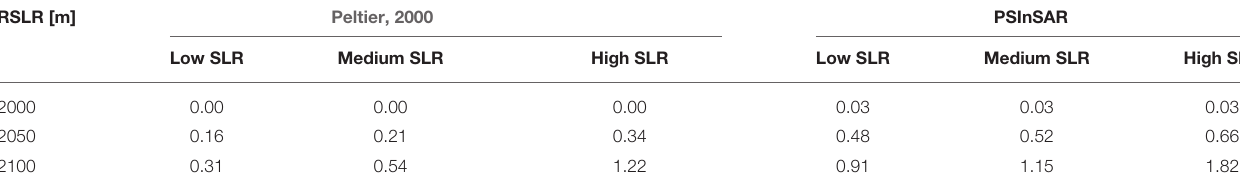
TABLE 7 | Comparison of relative sea-level rise values using the old DIVA and the PSInSAR